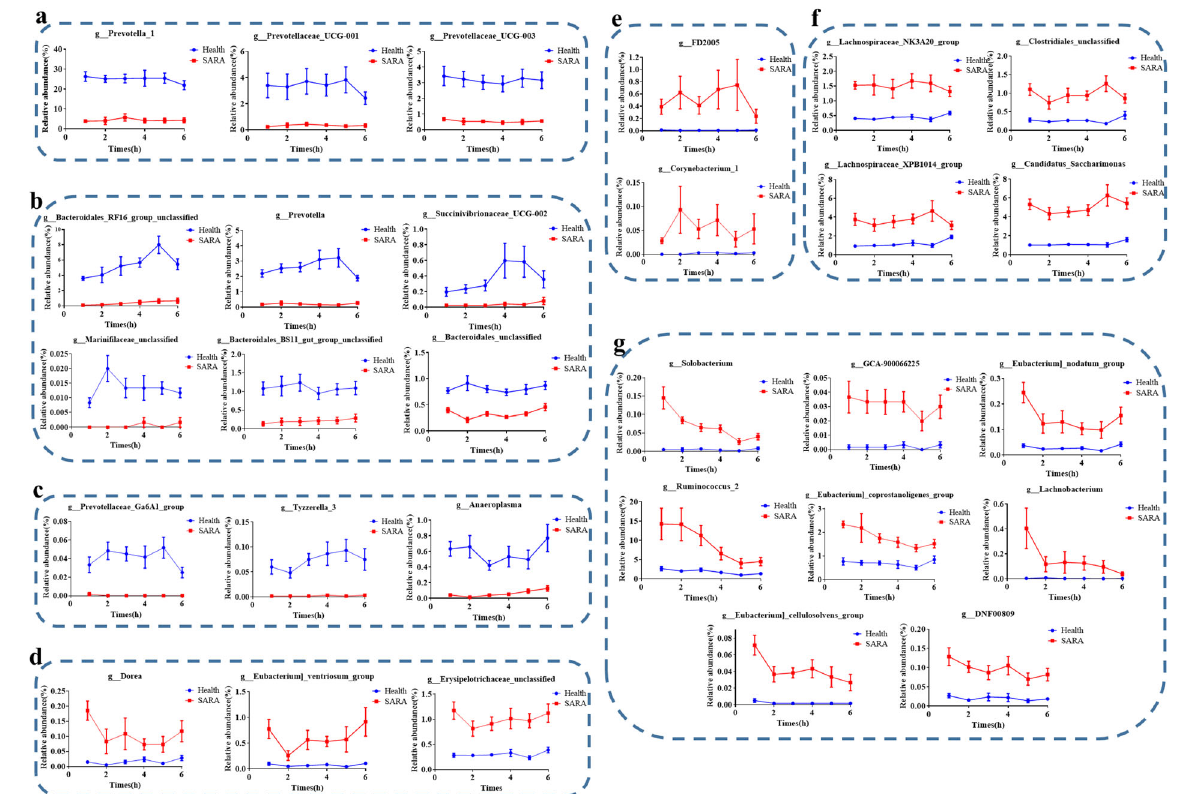
Fig. 3 Dynamic changes in the common rumen differential bacteria ( P < 0.05) during 6 h after feeding in donors from the SARA and healthy groups. a The relative abundance of the bacteria that increased signi fi cantly (FDR < 0.05) in the healthy group gradually decreased over time. b The relative abundance of the bacteria that increased signi fi cantly (FDR < 0.05) in the healthy group increased fi rst and then decreased over time. c The relative abundance of the bacteria that increased signi fi cantly (FDR < 0.05) in the healthy group has unique changing laws over time. d The relative abundance of the bacteria that increased signi fi cantly (FDR < 0.05) in the SARA group changed with time and shows a “ W ” shape. e The relative abundance of the bacteria that increased signi fi cantly (FDR < 0.05) in the SARA group changed with time and displays an “ M ” shape. f The relative abundance of the bacteria that increased signi fi cantly (FDR < 0.05) in the SARA group decreased fi rst, then increased and decreased over time. g The relative abundance of the bacteria that increased signi fi cantly (FDR < 0.05) in the SARA group gradually decreased over time. The Mann-Whitney U test was used with multiple comparisons adjusted by the Benjamini – Hochberg FDR to rank bacteria that were signi fi cantly different in their genus levels. All bacteria listed here were all signi fi cantly changed bacteria with FDR < 0.05 between SARA and Healthy groups in all 6 h after morning feeding. Health: the dairy goats from the healthy group, SARA: the dairy goats from the SARA group. Error bars on the graphs represent standard